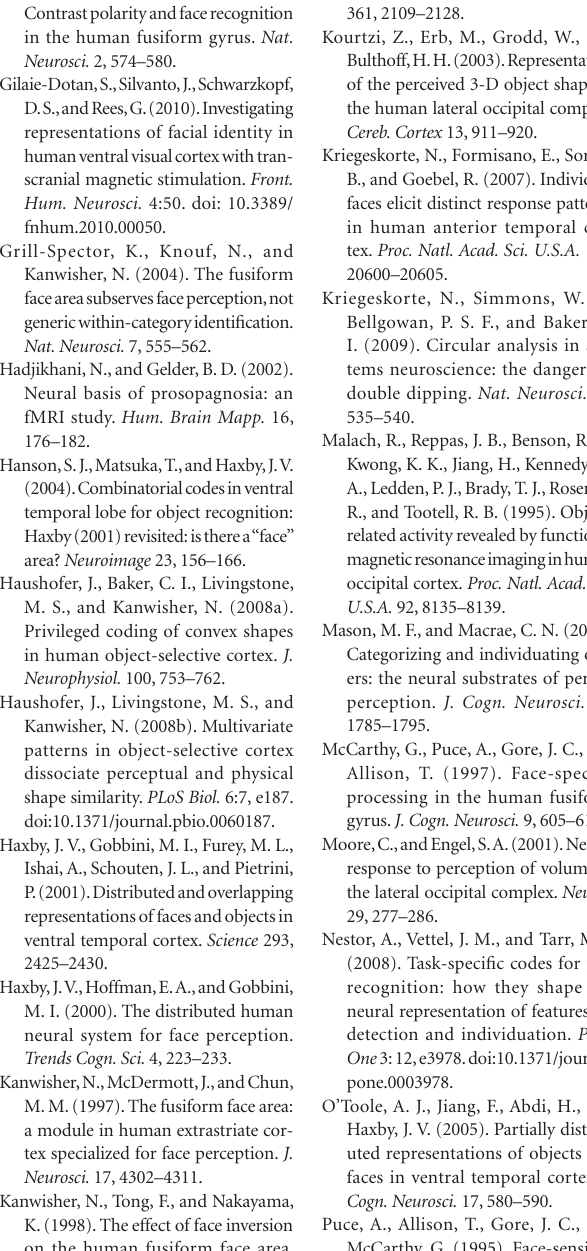
FFA: a flexible fusiform area for subordinate-level visual